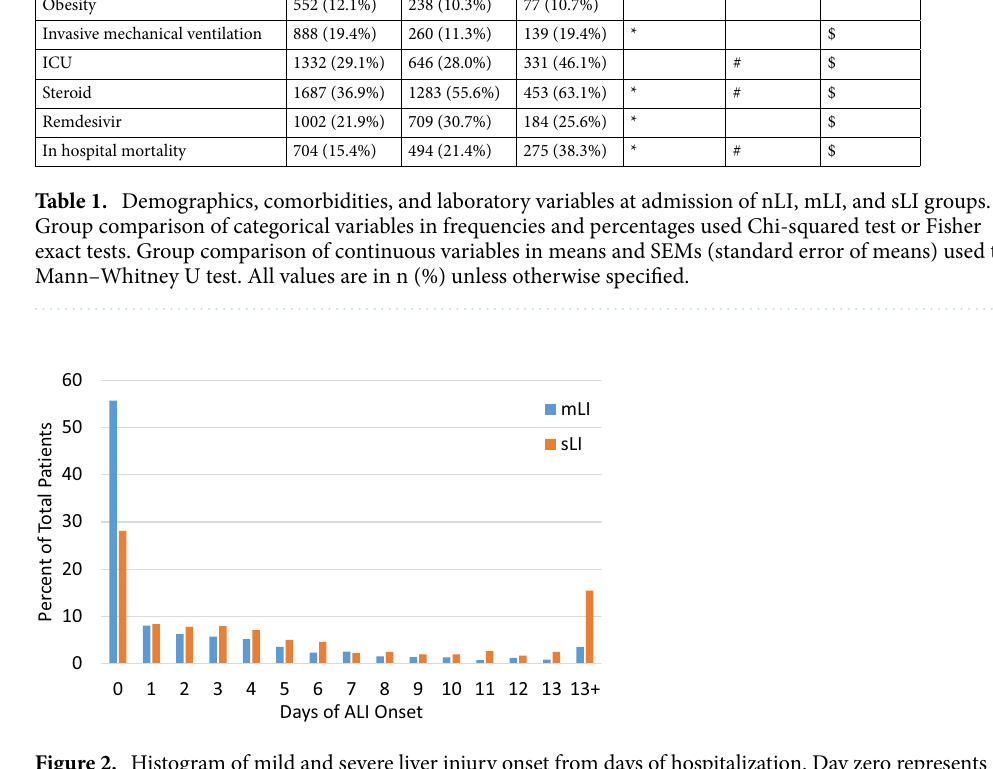
Figure 2. Histogram of mild and severe liver injury onset from days of hospitalization. Day zero represents admission date of patients. The average number of days patients developed mLI was 2.8 days and sLI was 6.7